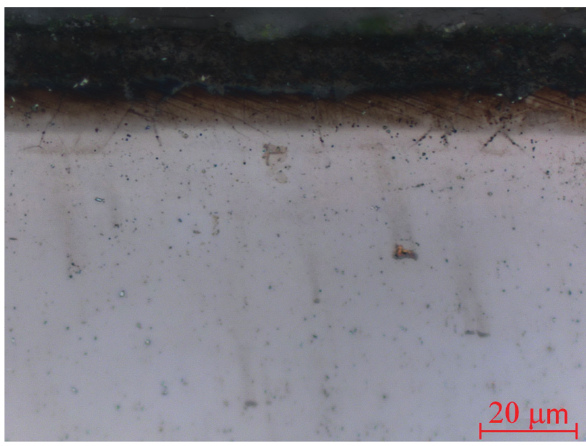
Figure 2: Cross-section of a nitrided sample, treatment time 20 min, nitriding temperature 470°C, sample bias – 500 V, sample current density 3.2 mA/cm 2 , layer microhardness 7.7 GPa.